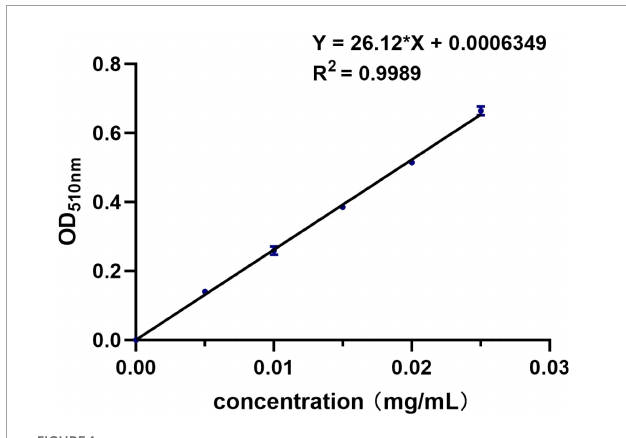
FIGURE1 Standard curve of the NaNO 2 -Al(NO 3 ) 3 -NaOH coloring